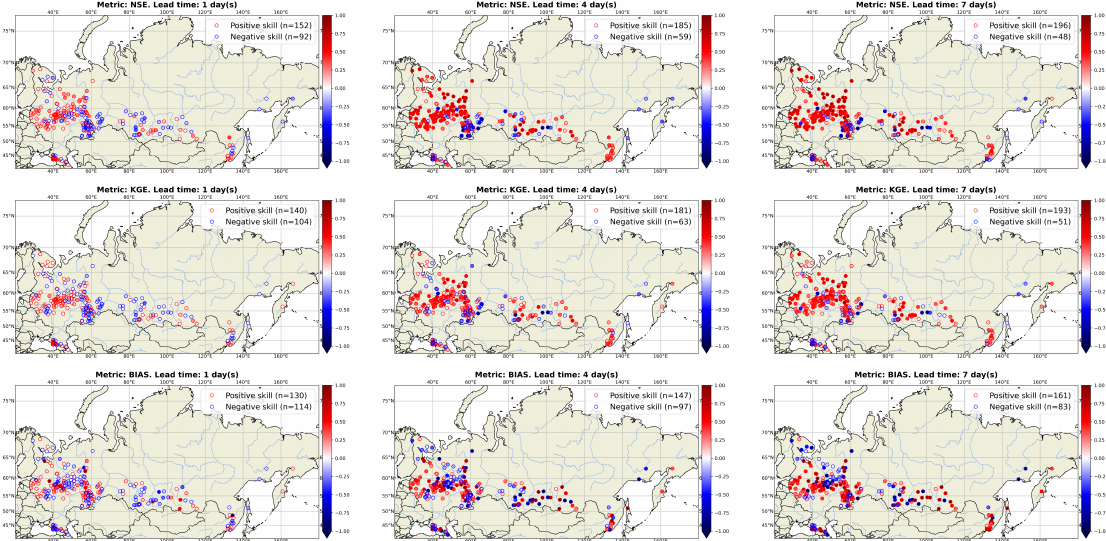
Figure 10. The skill of OpenForecastv2 with NSE (top row), KGE (middle row), and bias (bottom row) metrics for forecasts compared to the persistence benchmark for lead times of one (left column), three (middle column), and seven (right column)